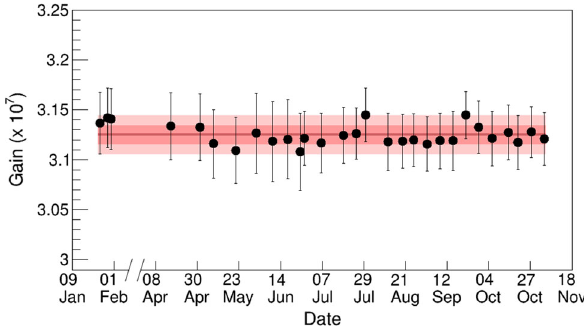
Fig. 4 Error-weighted mean gain (tenfold amplified) of the 16 SiPM channelsovertheentiredatatakingperiodin2019.Wemeasured ( 3 . 12 ± 0 . 01 ) × 10 7 . The ± 1 σ and ± 2 σ uncertainty bands around the mean are shown in red. Data with 83m Kr ( 37 Ar) was acquired before (after) the time-axis break period is ( 3 . 12 ± 0 . 01 ) × 10 7 at a bias voltage of 51 . 5